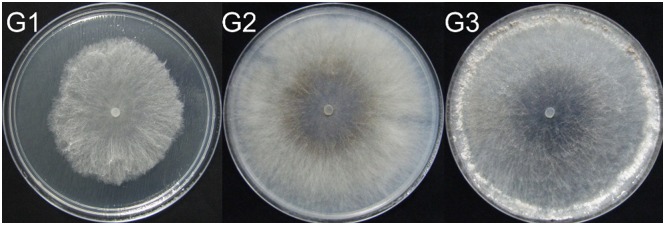
Phenotypes of vegetative (G1), undifferentiated (G2) and differentiated (G3) Rhizoctonia solani AG-1-IA in potato dextrose agar plates.G1: Culturing 36 hours post-inoculation while sealing the plate with a layer of preservative film. G2: Culturing 60 hours post-inoculation while sealing the plate with a layer of preservative film continuously. G3: Culturing 60 hours post-inoculation without sealing the plate beginning from 48 hours to 60 hours (the preservative film was removed at 48 hours). Differentiated sclerotia were formed in G3 due to unlimited aeration. After 48 hours of growth, the mycelia reached the edge of the Petri dish, but at 60 hours, the mycelia remained undifferentiated in G2 due to isolated aeration.